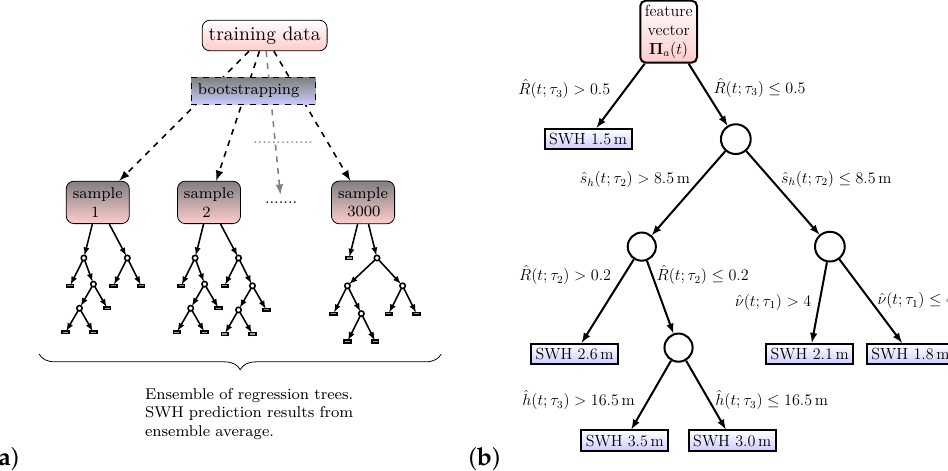
Figure 7. Simplified depiction of bagging for regression trees ( a ) and a fictive example ( b ) of a regression tree in the bagged ensemble for predictions with feature vector Π a